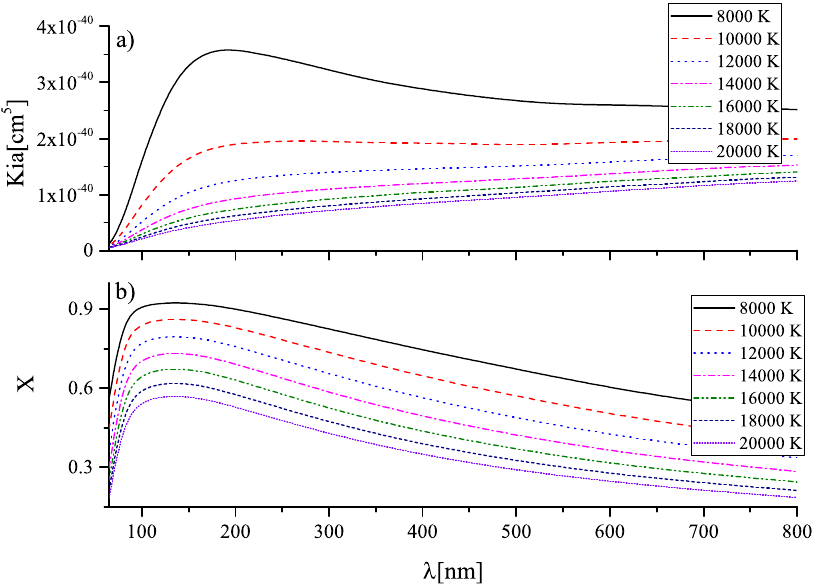
Figure 17. ( a ) the total absorption coefficient Kia as a function of λ and T ; ( b ) the branch coefficient X as a function of λ and T . Data from [27], case A =